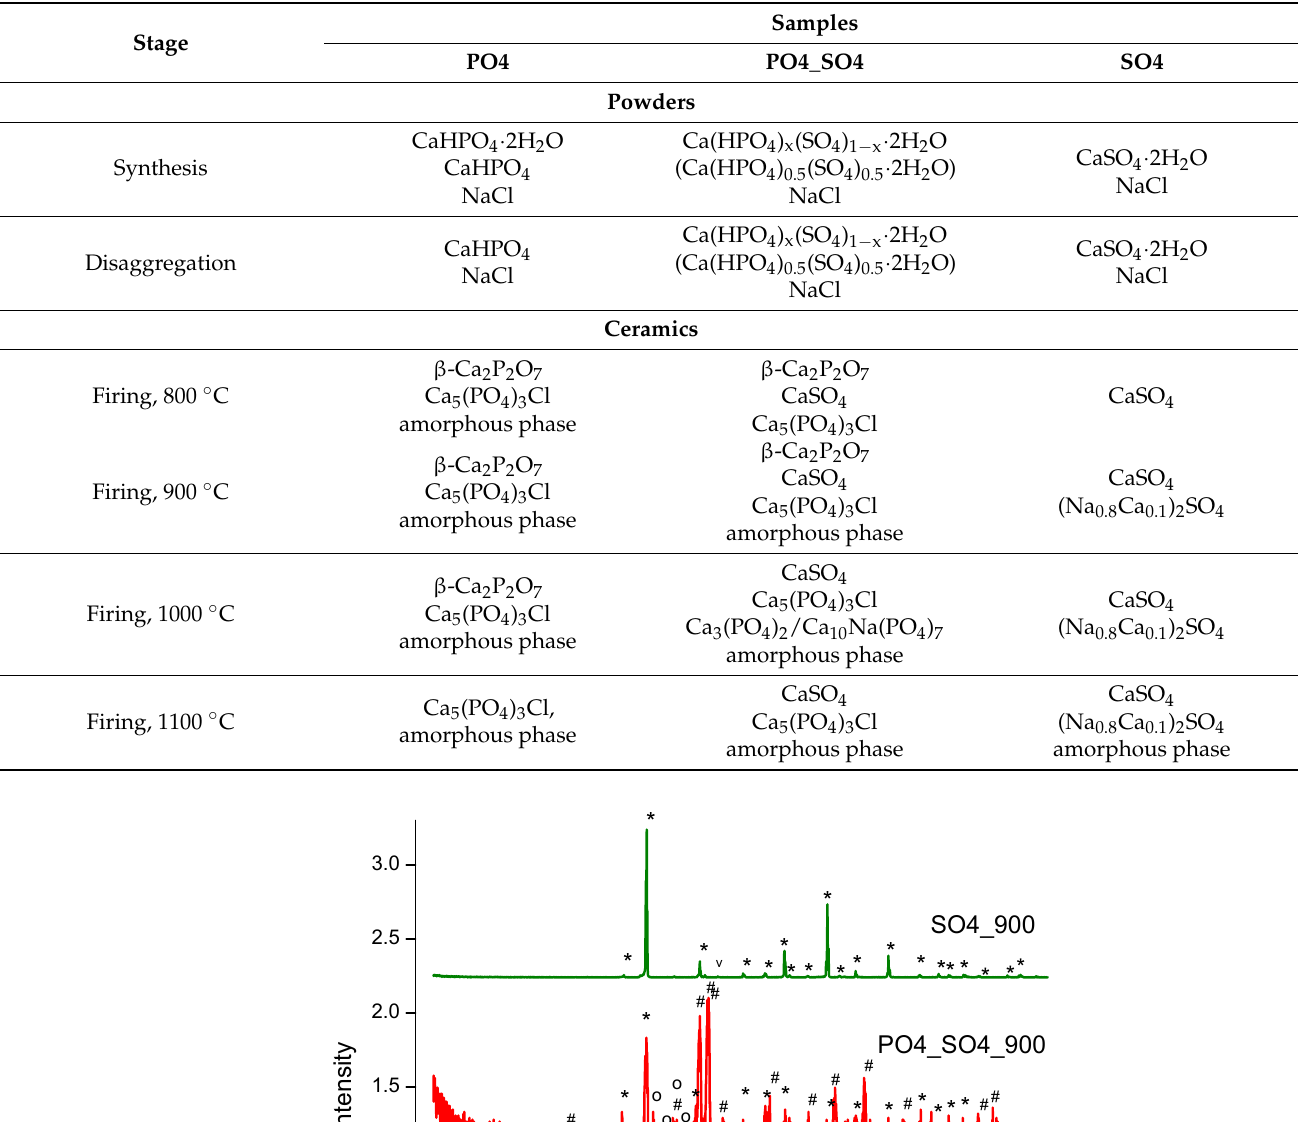
Table 5. Phase composition of samples at various stages of powder preparation and ceramics production.